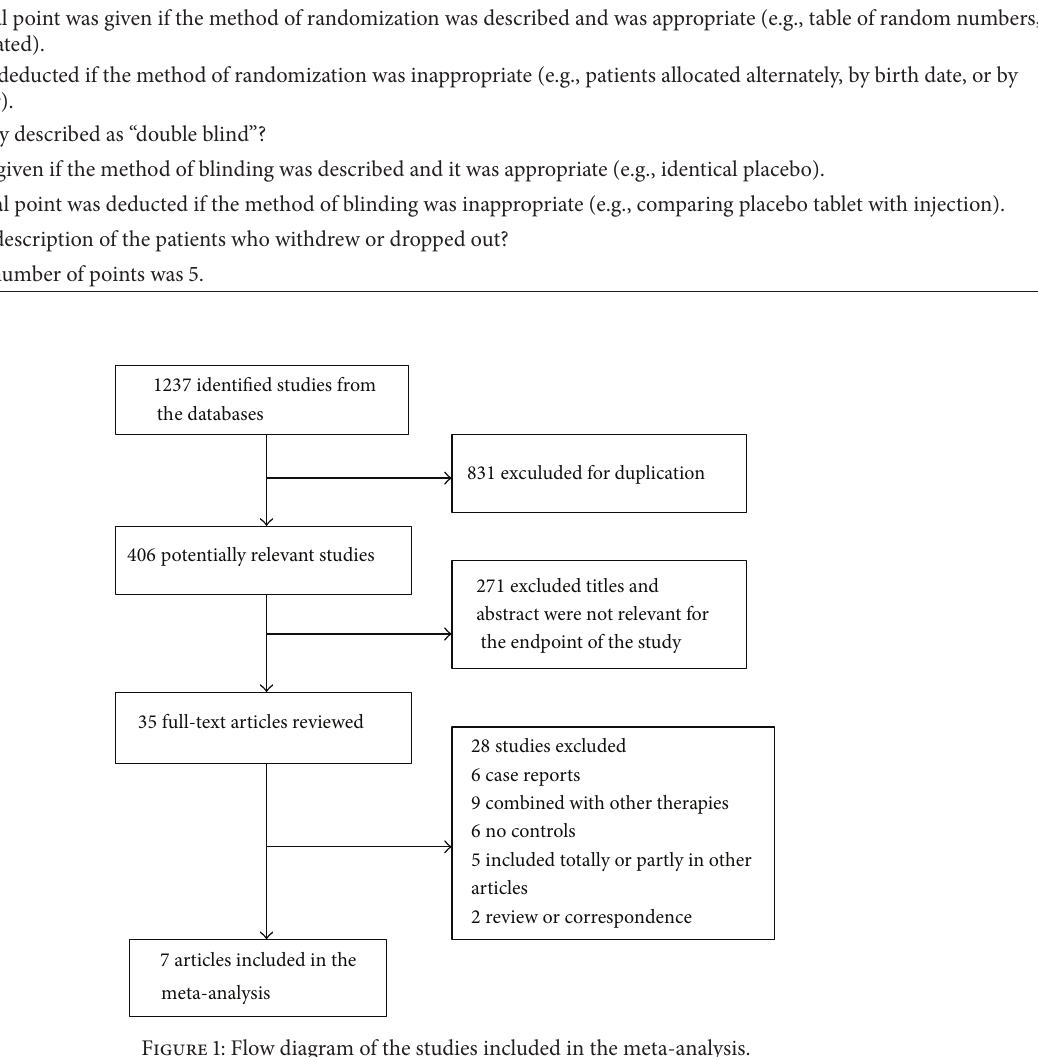
Figure 1: Flow diagram of the studies included in the meta-analysis.